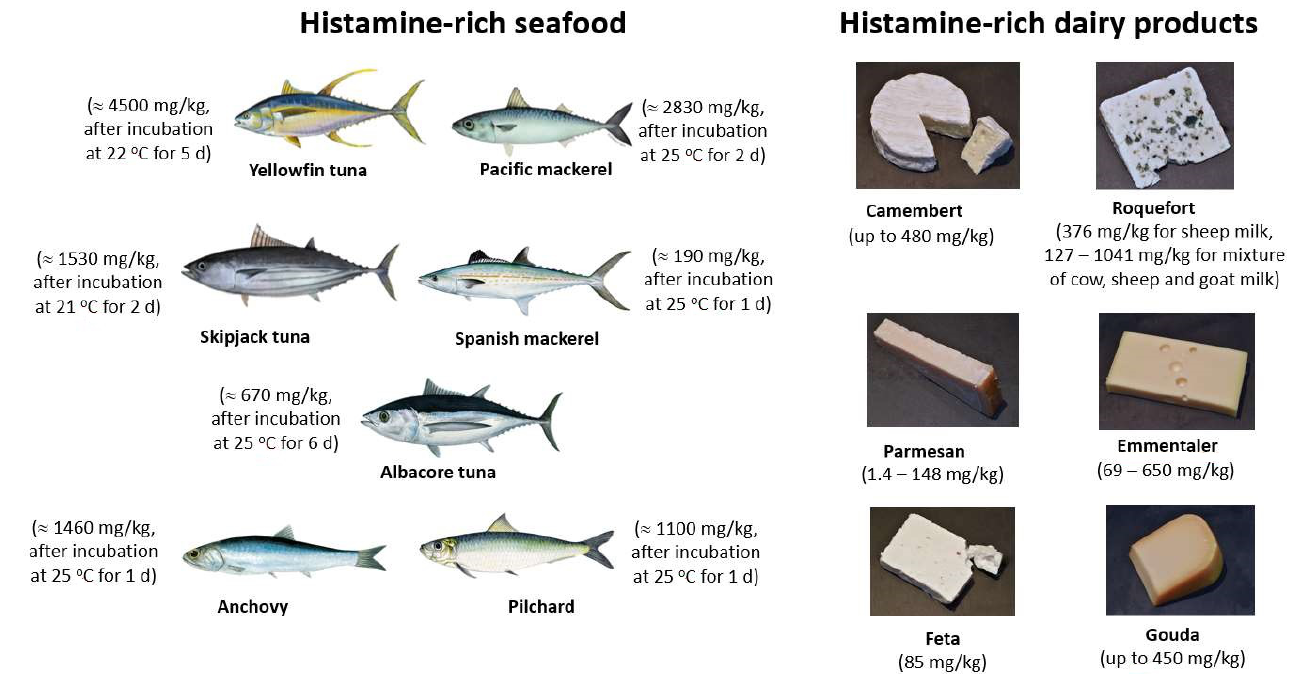
Figure 2. Seafood and dairy products containing ca. 100 mg histamine or more per kilogram. The given concentrations are either average values or indicate the minimum-maximum concentration range in mg/kg. In the case of fish, all samples were stored for at least one day at room temperature or slightly above. The histamine contents are based on the references [25,26,34]. The fish images are adopted from ref. [35], courtesy of NOAA Fisheries; the photographs of cheese types were provided by © Hans Hillewaert, ILVO.